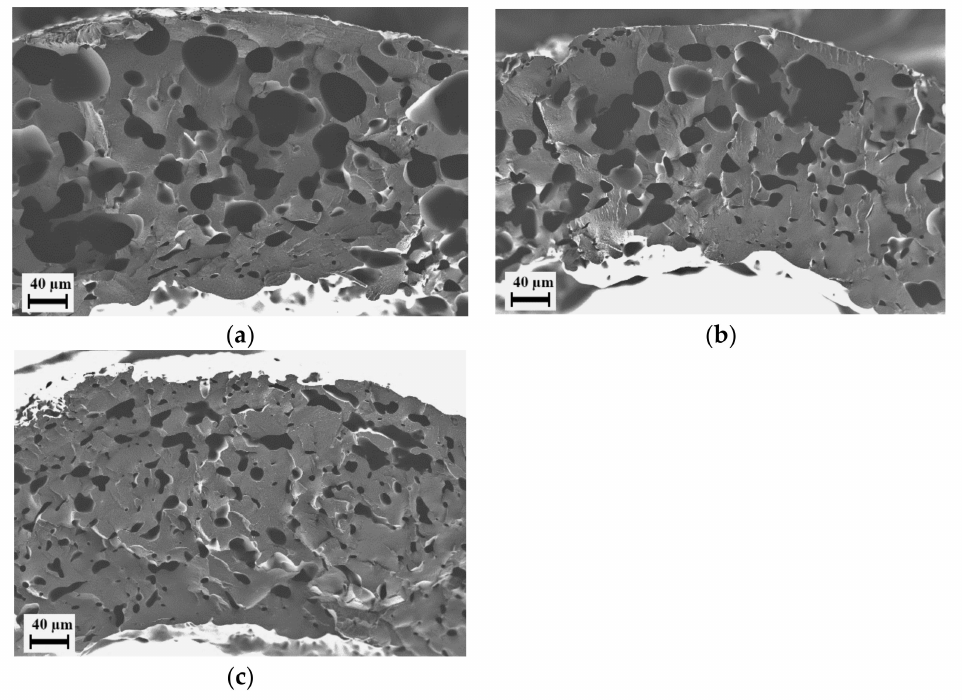
Figure 10. E3_PEG200_20 foams manufactured using only CO 2 as the foaming agent at various CO 2 feed rates: ( a ) 0.25 mL/min; ( b ) 0.5 mL/min; ( c ) 0.75 mL/min. Images show close-up views of the cross-section of the